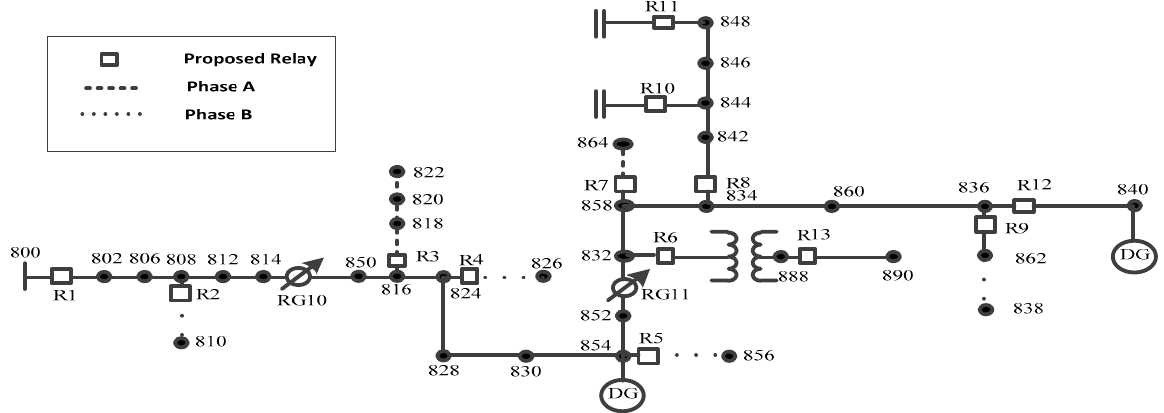
Figure 4. IEEE 34-bus test system with DGs and proposed relays.